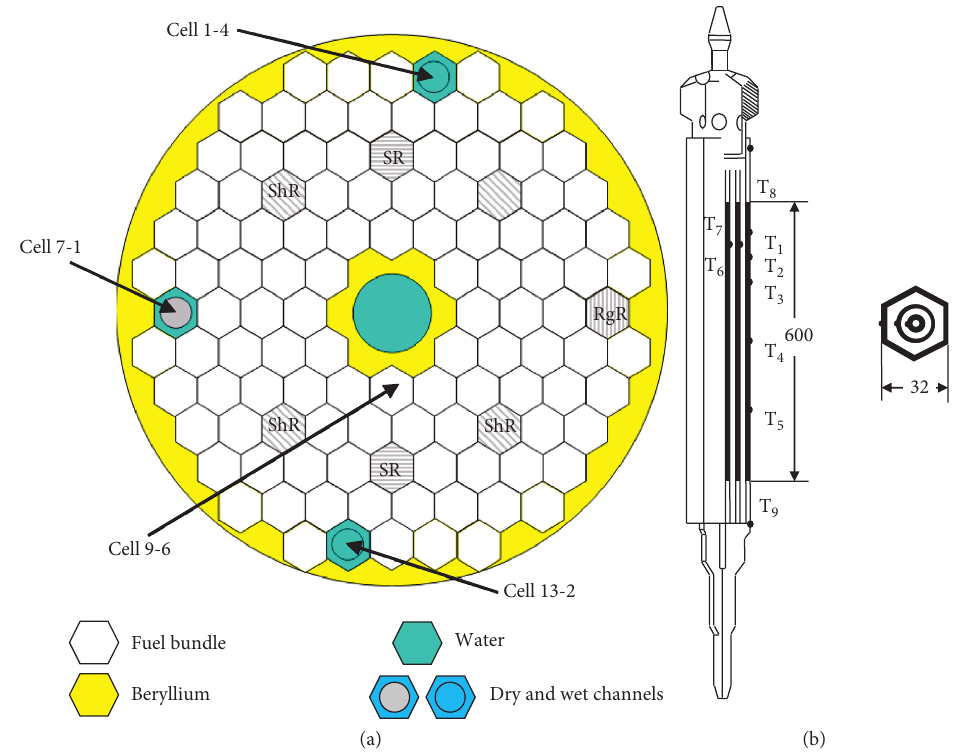
Figure 3: The reactor core configuration with 104 HEU VVR-M2 FBs (a) and IFB